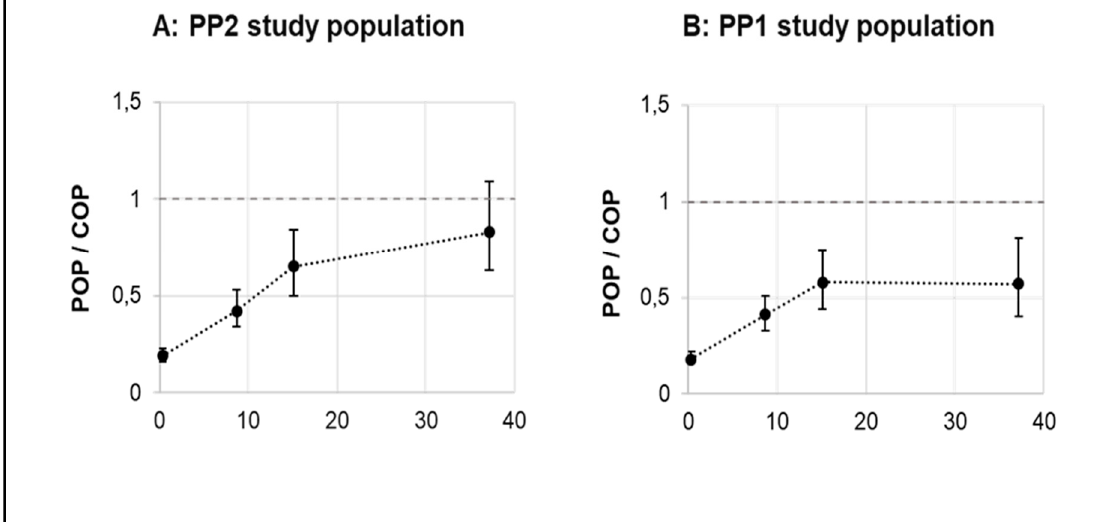
Figure 5. Ratio of total POP/total COP in serum with increasing dietary intakes of POP. Data are presented as mean plus 95% CI. Total COP and POP refer to the sum of all COP and POP measured including 7 ‐ keto and 7 α / β‐ OH derivates of PS and cholesterol, respectively. Stabilized total POP concentration refers to the steady ‐ state concentration as modelled over the six ‐ week intervention. For PP2 study population ( A ): All study participants, n = 52 ( n = 14 in control, n = 15 in low POP dose, n = 13 in medium POP dose and n = 10 in high POP dose group). For PP1 study population ( B ): All study participants, n = 59 ( n = 14 in control, n = 15 in low POP dose, n = 15 in medium POP dose and n = 15 in high POP dose group).